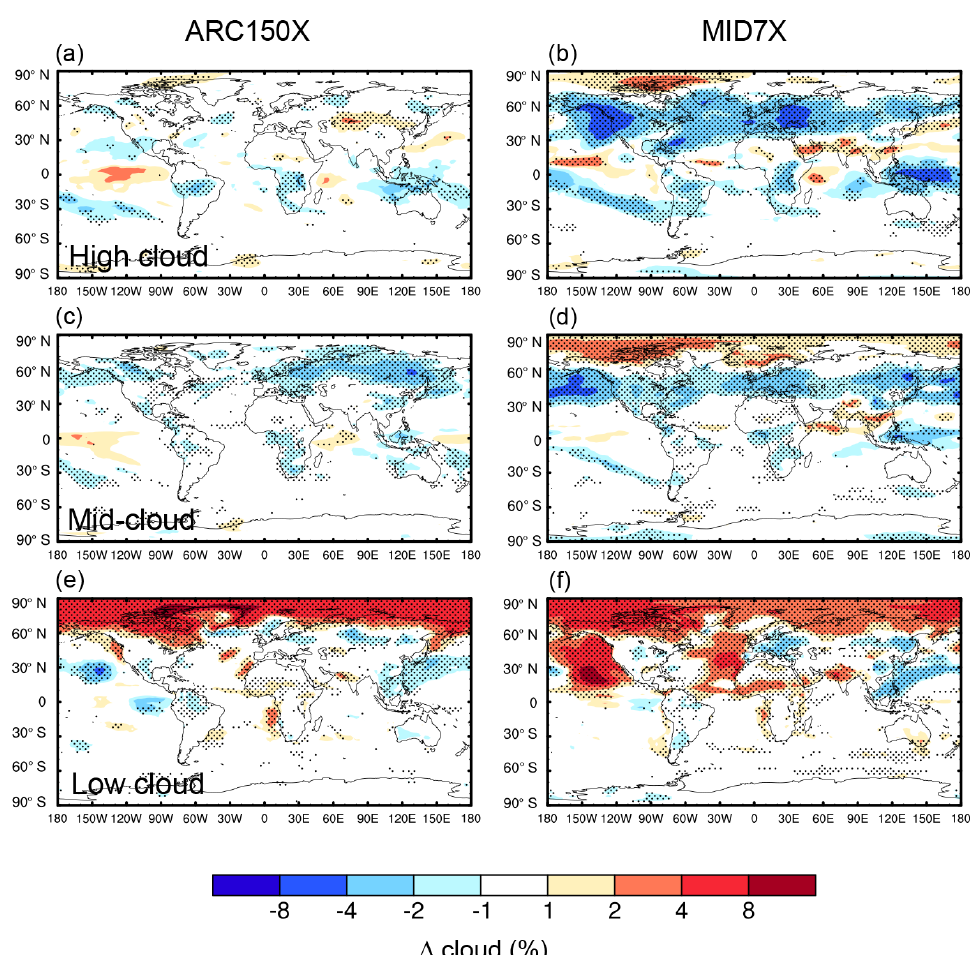
Figure 6. Changes in annual mean high (a, b) , mid-level (c, d) , and low (e, f) cloud fraction (%) for ARC150X (a, c, e) and MID7X (b, d, f) compared to PD. The dotted areas indicate statistical significance with 95% confidence from a two-tailed Student’s t